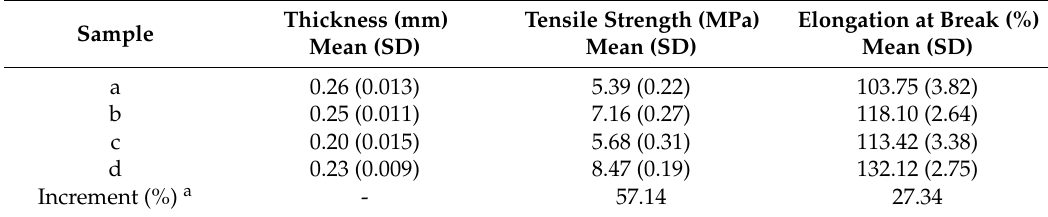
Table 3. Thickness and mechanical properties of the SPI-based films a–d.